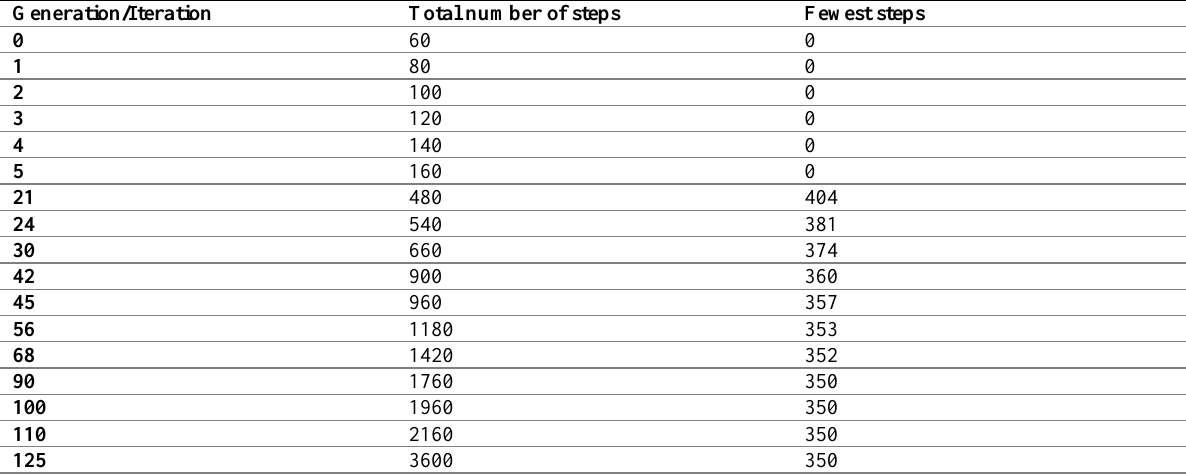
Table 2: Data collected from the conducted